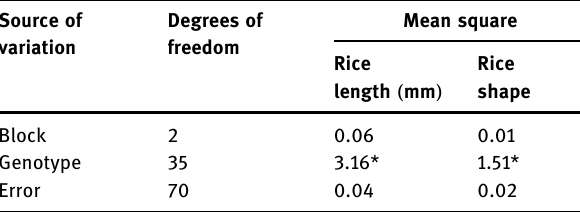
Table 2: Analysis of variance for F 1 in a full diallel cross for length